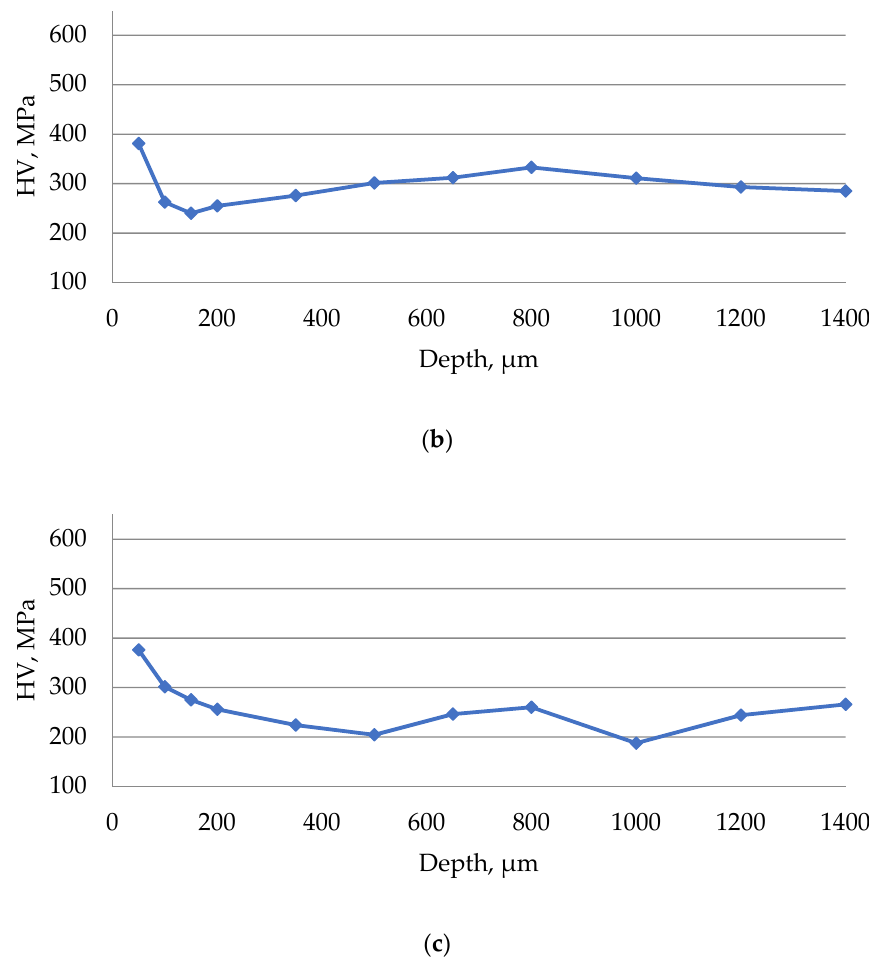
Figure 14. The results of measuring the microhardness of the surface of steel 15 after EDM in the finishing mode using ETs from: ( a ) copper; ( b ) graphite; ( c ) composite. The results of the study of the microhardness of the surface of steel 15 after EDM in the rough mode are presented in Figure 15.